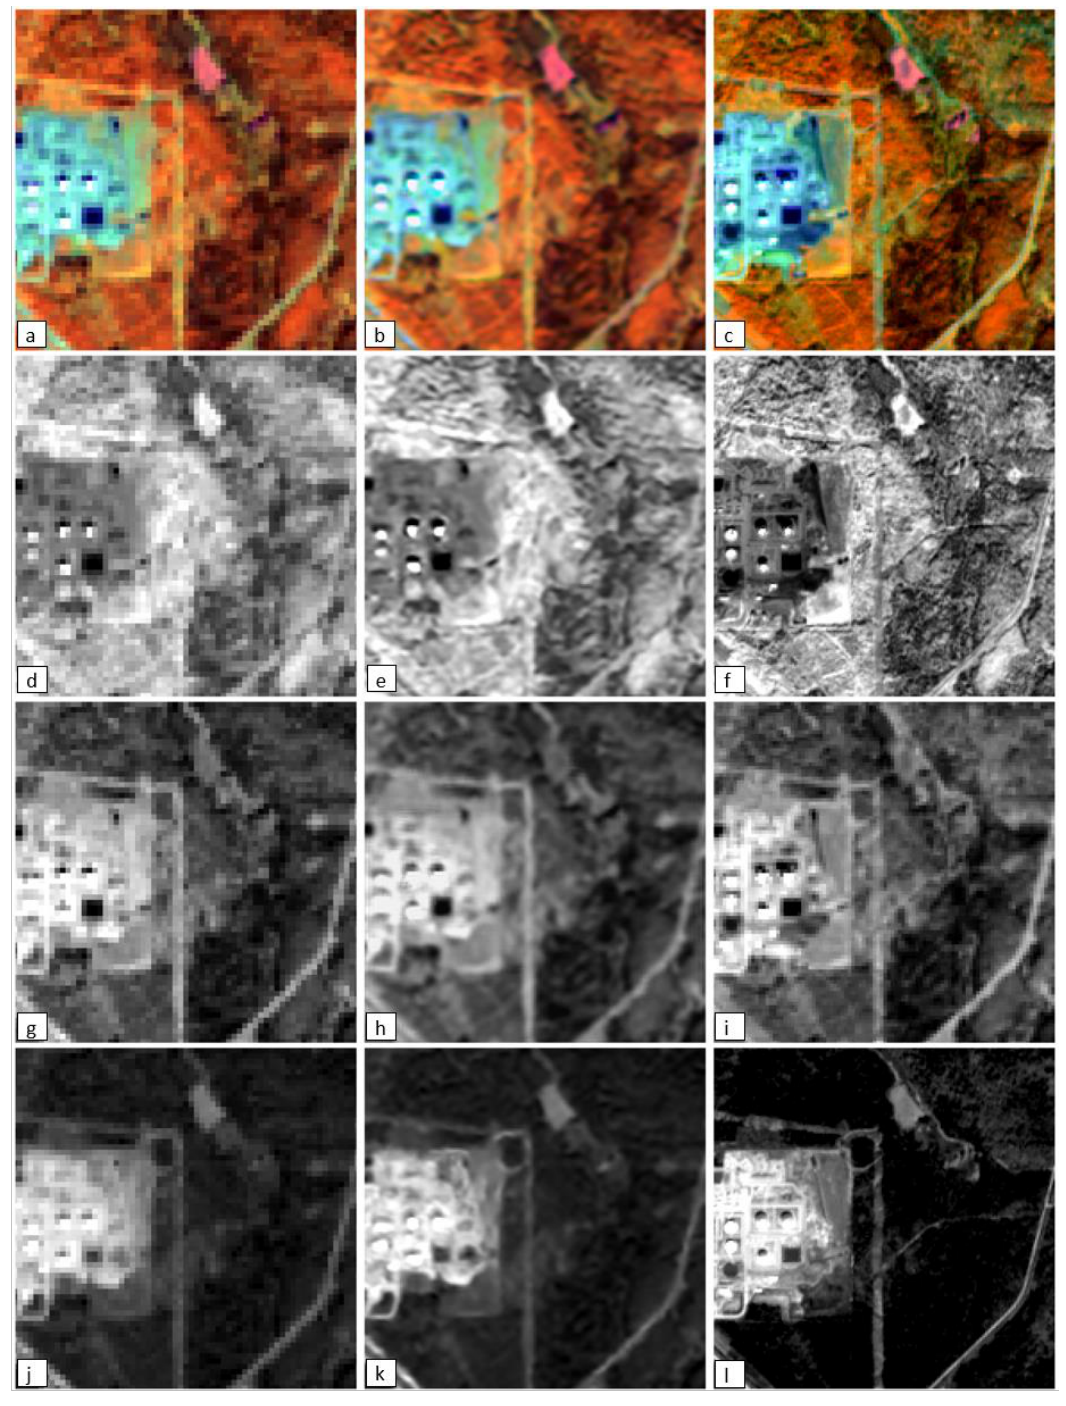
Figure 4. Example results for each band for a mixed boreal forest with some industrial development; ( a,d,g,j ) Landsat image, ( b,e,h,k ) resolution enhanced, and ( c,f,i,l ) Sentinel-2 image. ( a,b,c ) multi-band ( a , d , g , j ) Landsat image, ( b , e , h , k ) resolution enhanced, and ( c , f , i , l ) Sentinel-2 image. ( a – c ) multi-band image displayed as red = NIR, green = SWIR, blue = red, ( d,e,f ) NIR, ( g,h,i ) SWIR, (j,k,l) red. image displayed as red = NIR, green = SWIR, blue = red, ( d – f ) NIR, ( g – i ) SWIR, ( j – l )